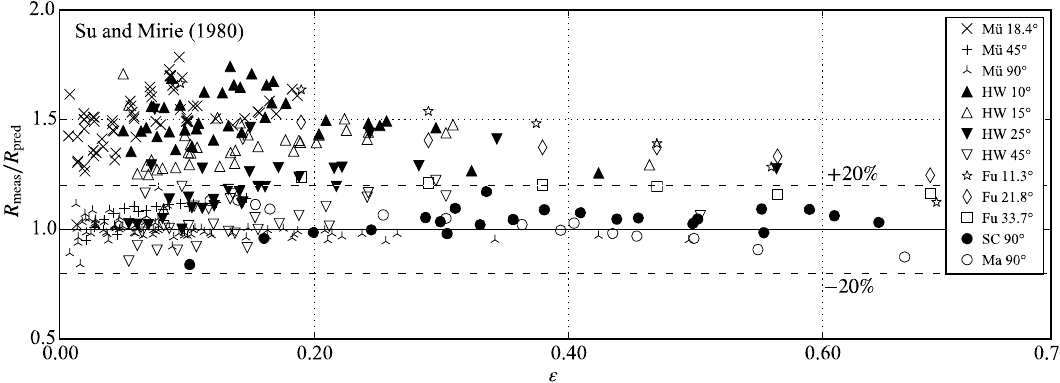
Figure 9. Measured over predicted (Equation (6) by Su and Mirie [17]) runup height R meas / R pred versus relative wave crest amplitude ε for experiments from data sources from Müller (Mü) [7], Hall and Watts (HW) [14], Fuchs (Fu) [20], Street and Camfield (SC) [21], and Maxworthy (Ma) [19].